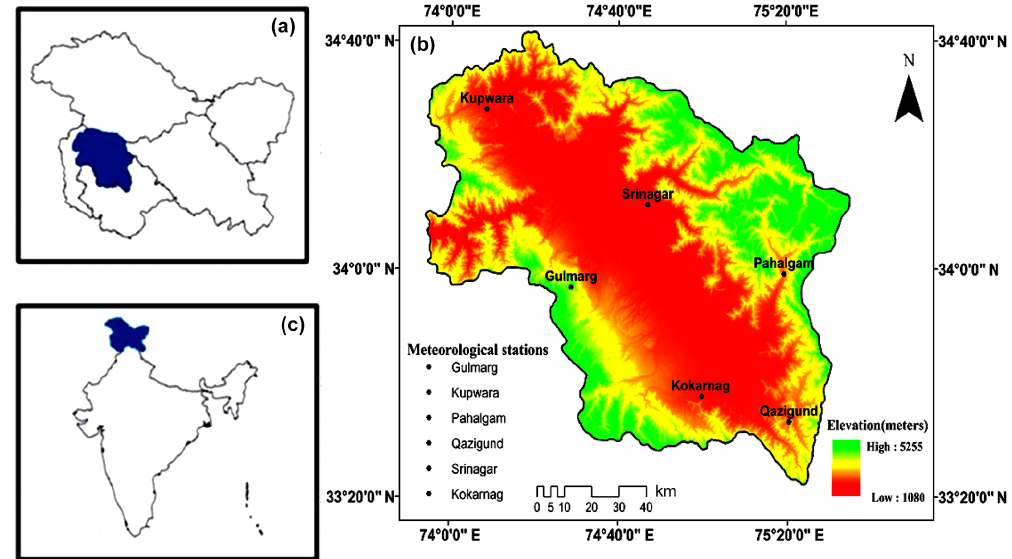
Figure 1. Geographical setting of the Kashmir valley (b) inside the Jammu and Kashmir state (a) of India (c) along with marked locations of six meteorological observation stations: Srinagar, Gulmarg, Pahalgam, Kokarnag, Qazigund and